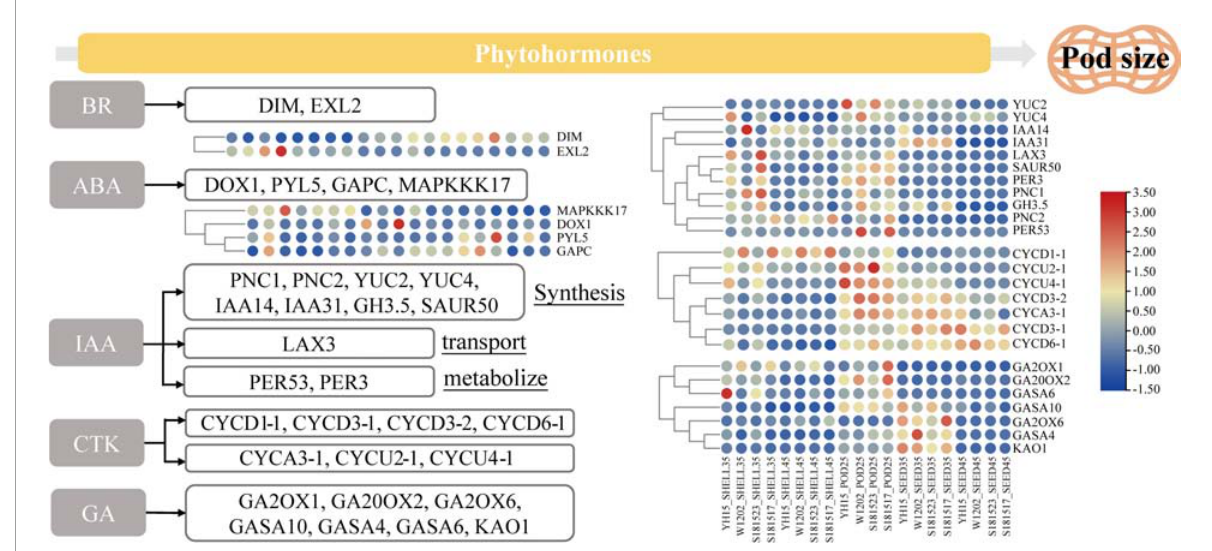
FIGURE8 Heat map shows the relative expression of DEGs in BR, ABA, IAA, CTK, and GA phytohormone pathways. From red to blue, it indicates that the relative expression level is from high to low. The order of the sample IDs in the left figure is the same as in the right figure.